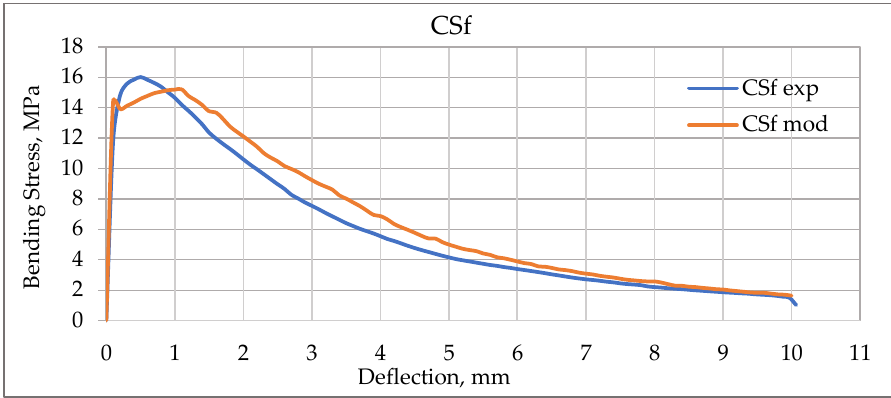
Figure 5. Experimental and modelling data comparison for materials in the group CSf.